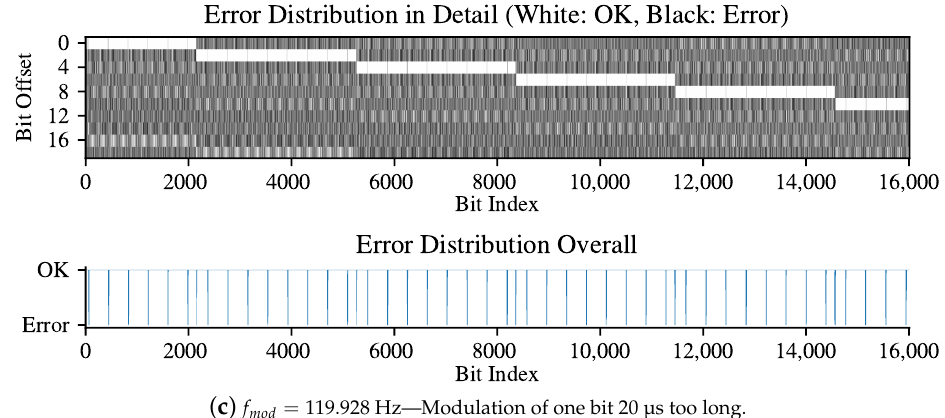
Figure 18. Error distribution for different qualities of